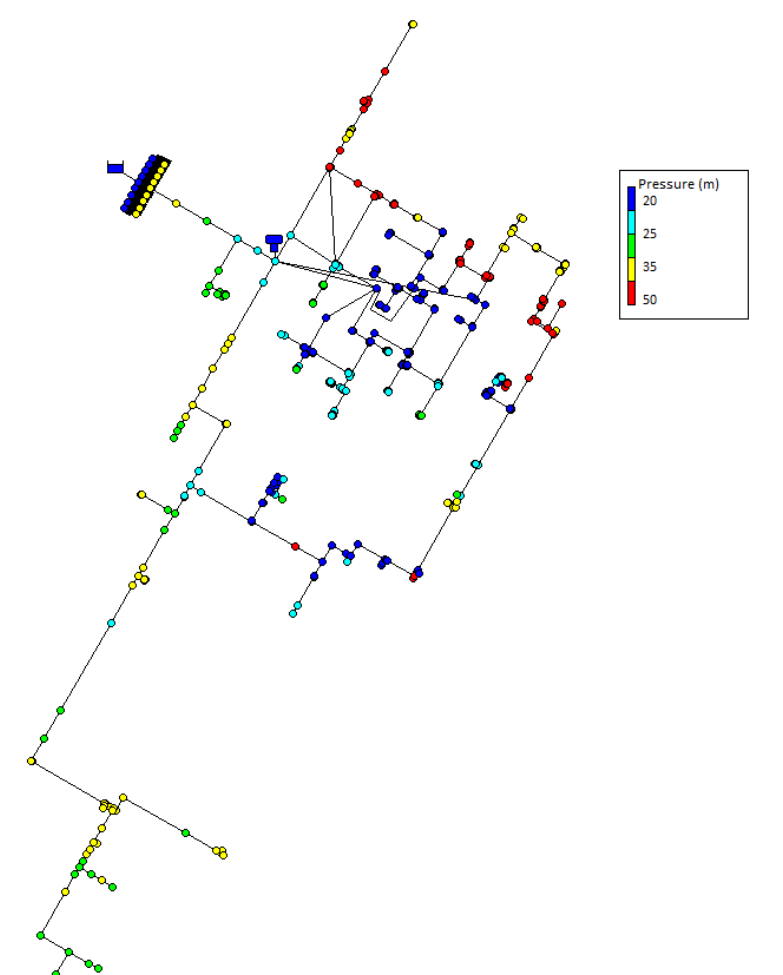
Figure 7. Lowest nodal pressures for Scenario 20% − 1 P at 9:00 p.m. on a day with no rainfall in the previous 24